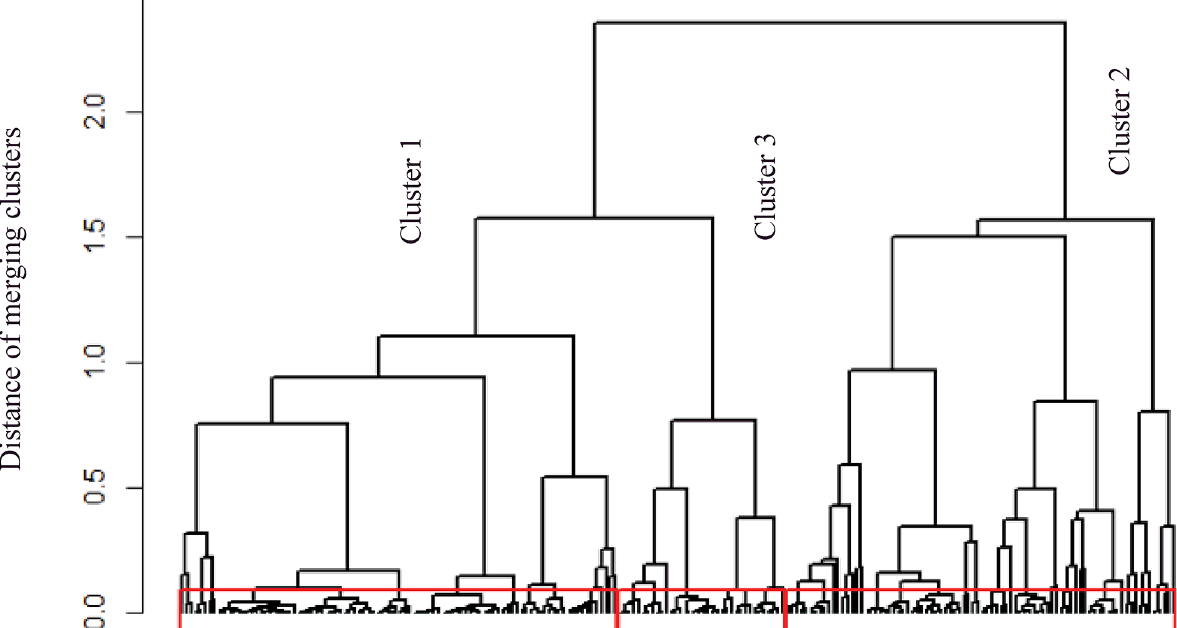
Fig 1. Dendogram for the entire population (n = 214), obtained with a hierarchical bottom-up clustering. Three clusters were apparent. This agglomerative approach begins with each subject as a separate cluster and merges them into successively larger clusters. By Ward ’ s linkage, samples were merged into larger clusters to minimize the within-cluster sum of squares. Cluster 1: “ AD with low sensitization ” , cluster 2: “ AD with multiple sensitizations ” , cluster 3: “ AD with familial history of asthma ” .